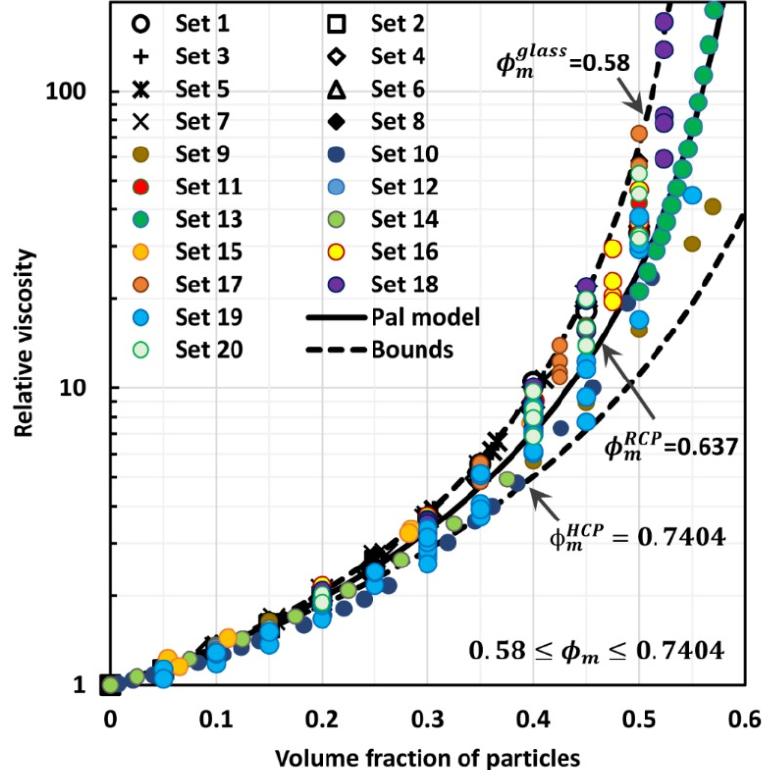
Figure 13. Upper and lower bounds predicted from the proposed model, Equation (34). Upper bound with φ m = φ Glass m = 0.58 and lower bound with φ m = φ HCP m = 0.7404.